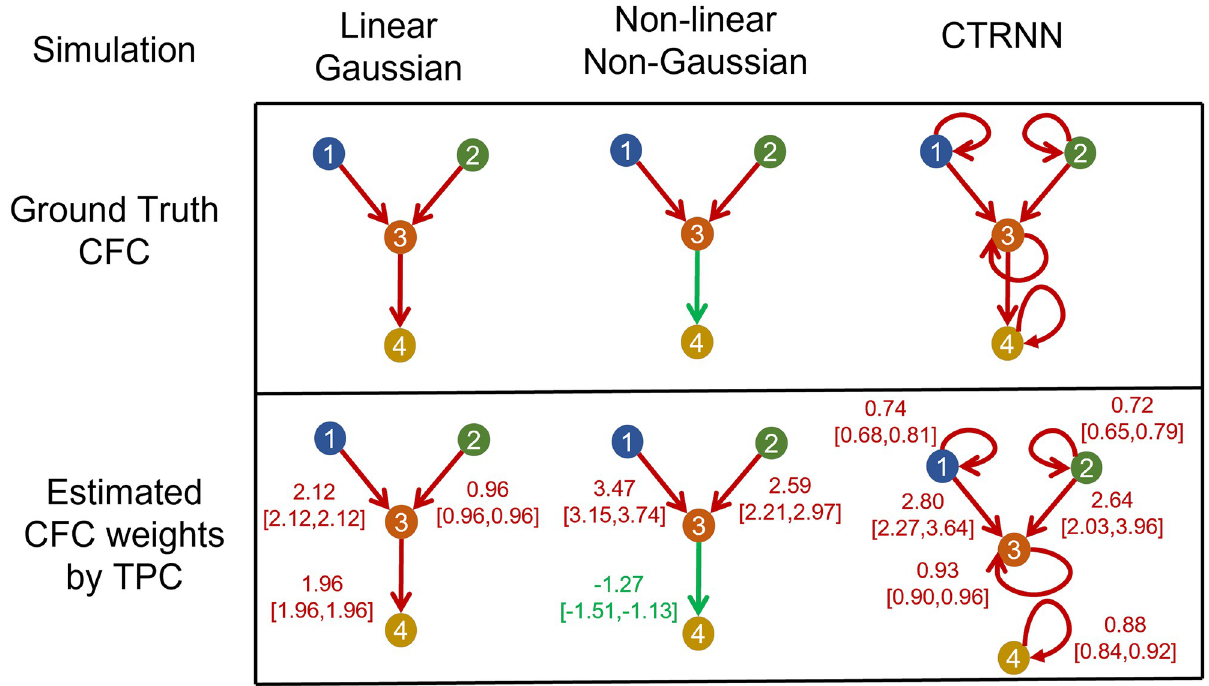
Fig 5. Interventional connectivity weights. Inference of interventional connectivity weights by the TPC algorithm with max delay 1 msec for the example motifs from the three simulation paradigms: Linear Gaussian VAR, Non-linear Non-Gaussian VAR, CTRNN (left to right). Top row: Ground Truth CFC with excitatory (red) and inhibitory (green) connections; Bottom row: Estimated CFC labeled with edge weights (median [min,max] over all instances) and inferred nature whether excitatory (red) or inhibitory (green).